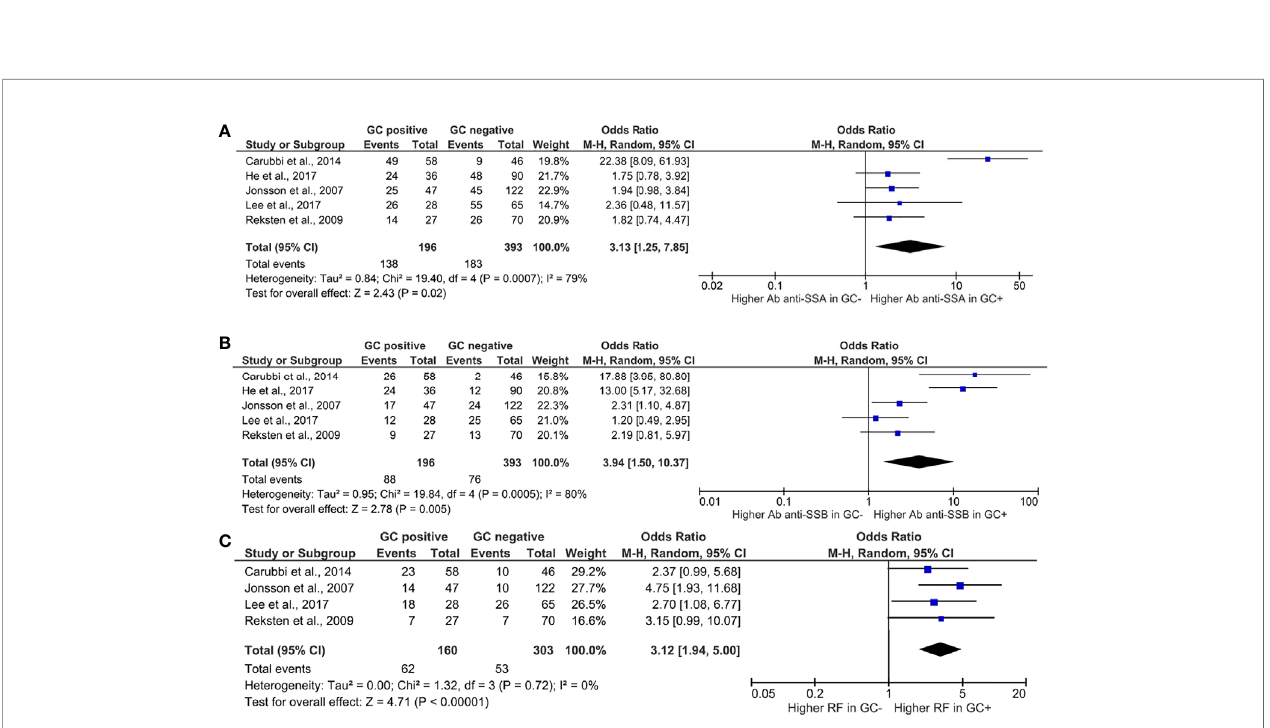
FIGURE 3 | Meta-analysis of the presence of anti-SSA (A) , anti-SSB (B) , and rheumatoid factor (C) between patients with Sjögren ’ s syndrome with or without ectopic germinal center. The size of squares is proportional to the weight of each study. Horizontal lines indicate the 95% CI of each study; diamond, the pooled estimate with 95% CI; N, the number of persons at baseline; and OR, odds ratio; GC, germinal center; RF, rheumatoid